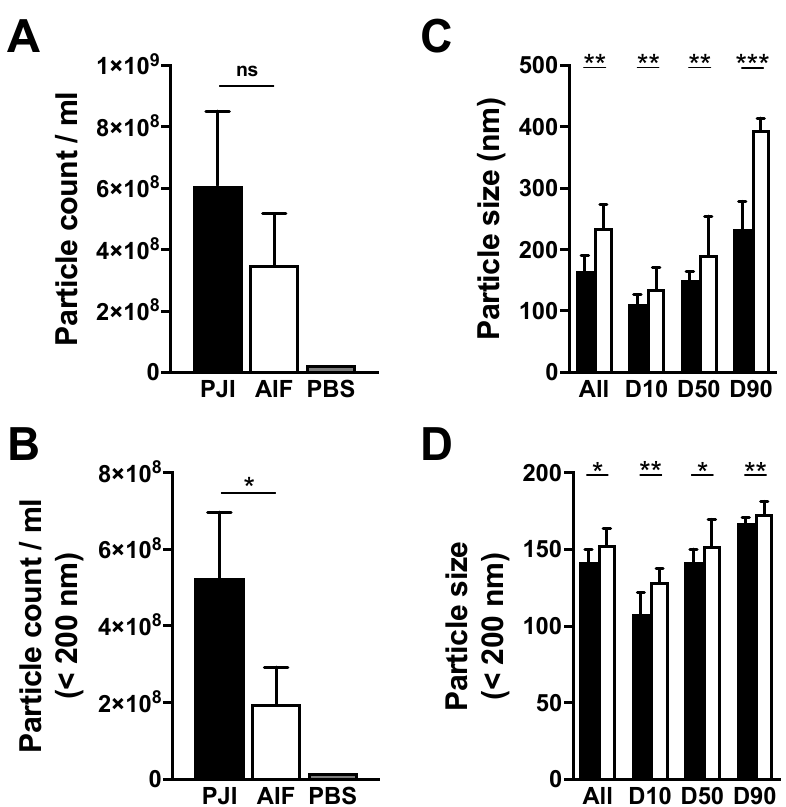
Figure 2. Selected representative electron microscopy images evidencing extracellular vesicle presence in both groups.